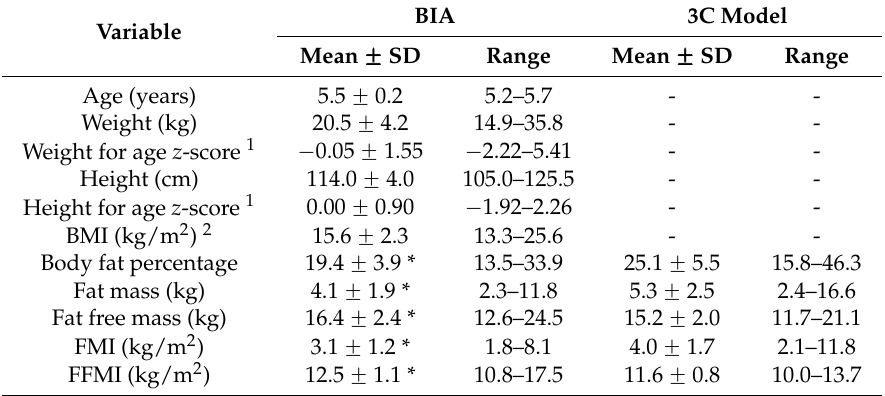
Table 1. Age, weight, and height as well as body composition variables by means of bioelectrical impedance analysis (BIA) and three component (3C) model for the participating children ( n = 40).